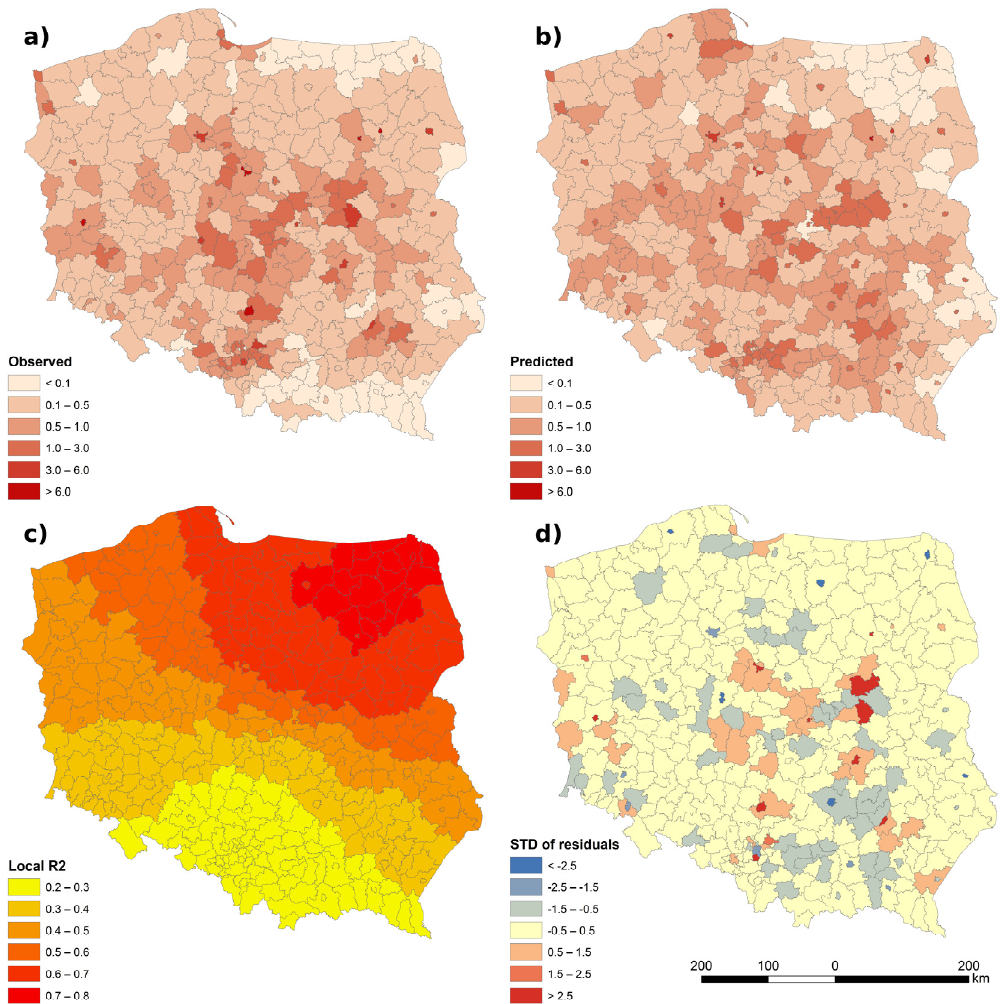
Figure 5. Spatial distribution of observed ( a ) and predicted ( b ) density of forest fires (number of fires per square kilometer of forest area), locally adjusted determination coefficients, R 2 ( c ), and standard deviations of regression residuals ( d ).